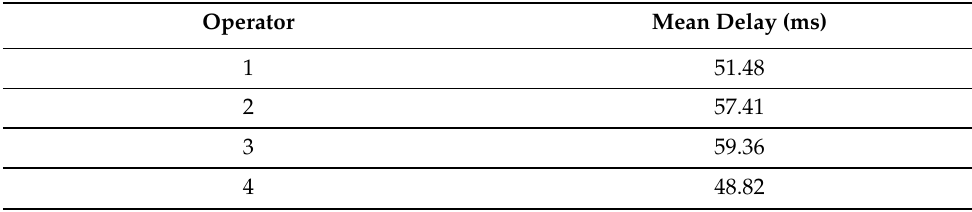
Table 1. Mean end-to-end delay for four UK